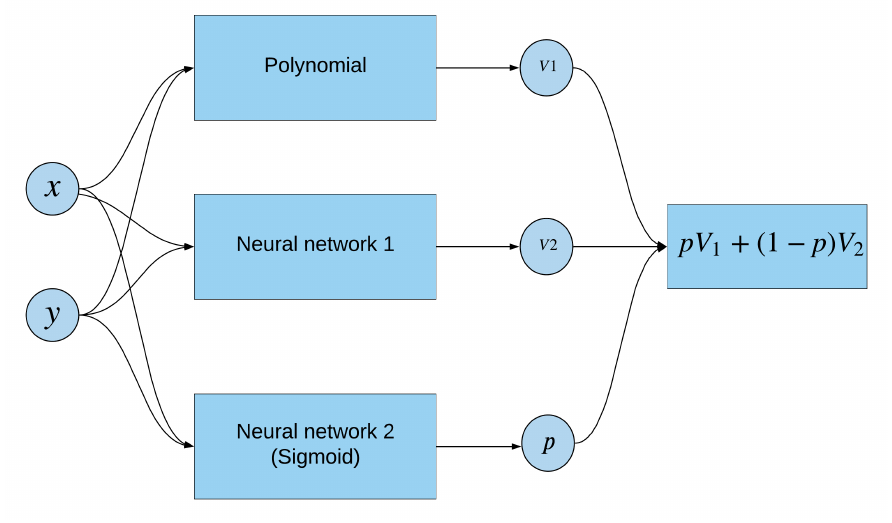
Figure 2. Improving exponential